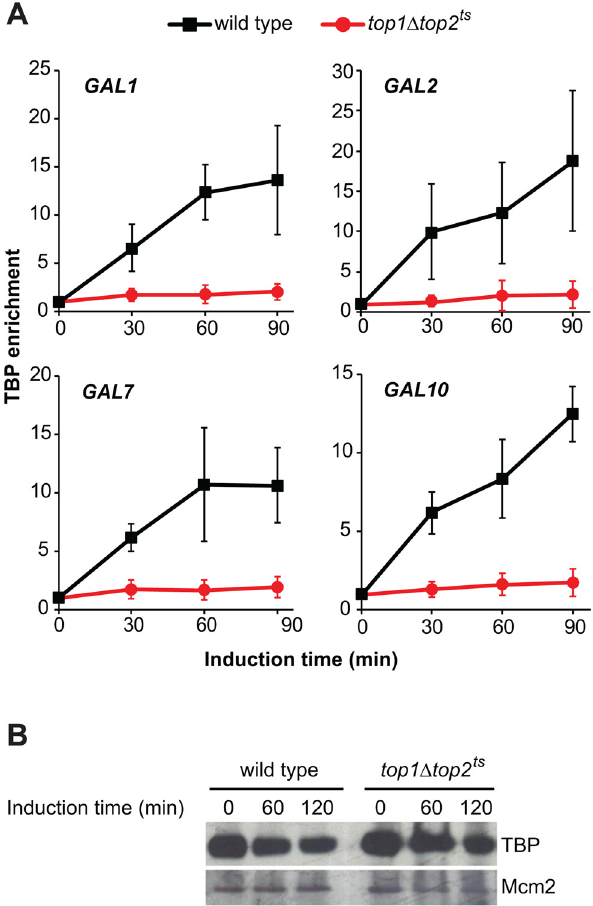
Experimental setup was as described for Fig 1B. ChIP was performed on cells having the endogenous TBP protein fused to a HA epitope tag using anti-HA antibodies. TBP binding levels were normalized relative to the binding under uninduced conditions at the 0 min time point (set to 1). Averages from three individual experiments are shown, and error bars represent ± one standard deviation. Positions of primers used in